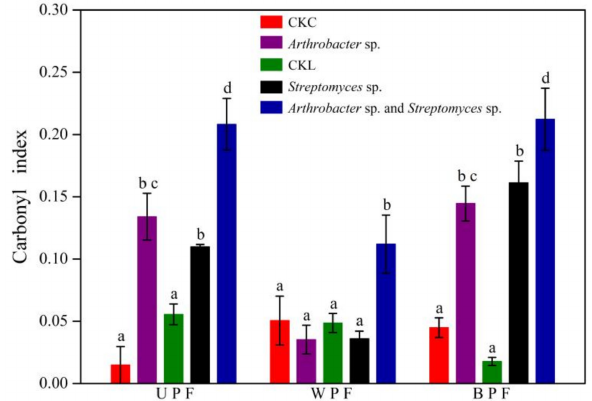
Figure 4. E ff ects of bacterial incubation for 90 days on the carbonyl indices of polyethylene films. UPF, WPF, and BPF are defined in Figure 2. The abbreviations CKC and CKL are also the same as those used in Figure 2. Bars indicate the mean ± SE (n = 3), and bars with di ff erent letters are significantly di ff erent ( p < 0.05, two-way ANOVA and Fisher’s protected LSD